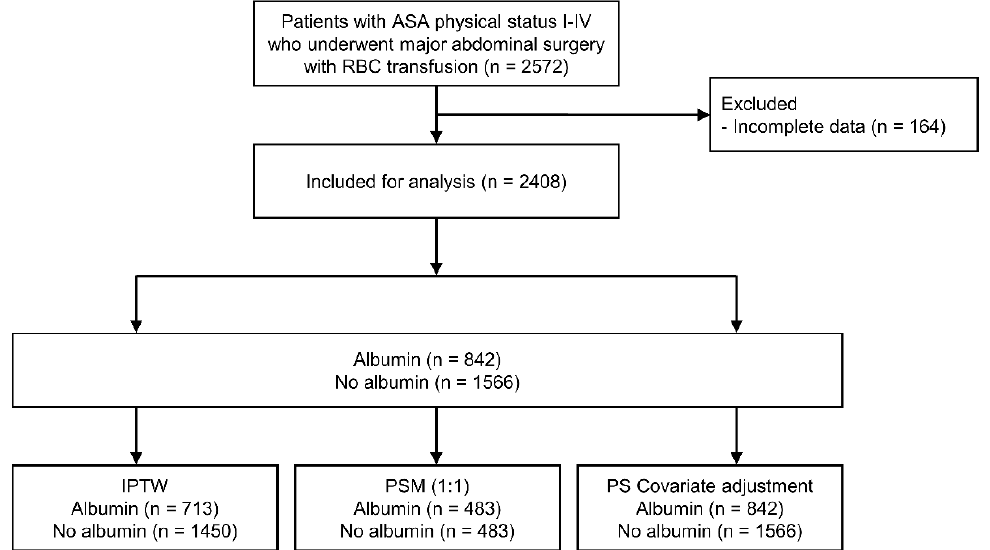
Figure 1. Flow chart of patient selection. ASA, American Society of Anesthesiologists; RBC, red blood cell; IPTW, inverse probability of treatment weighting; PSM, propensity score matching; PS, propensity score.